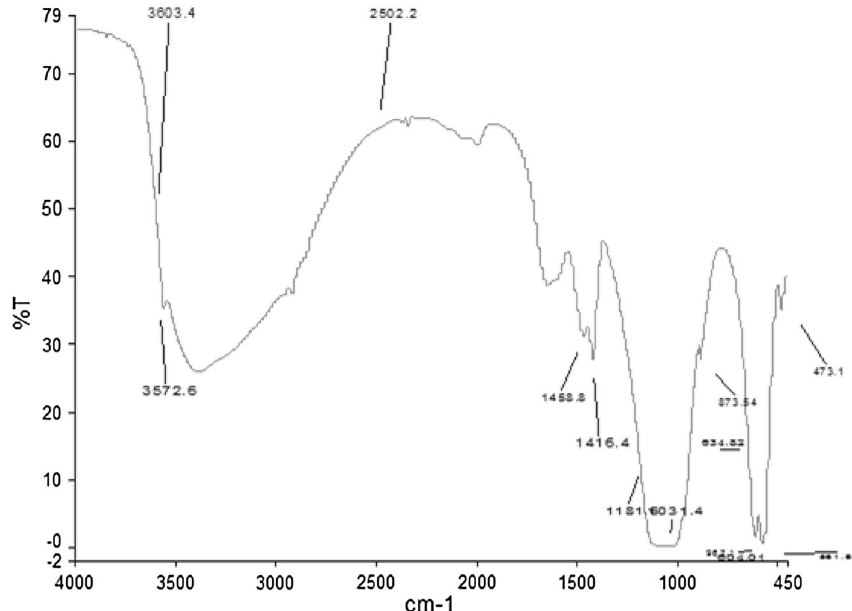
Fig. 2 FT-IR spectrum of syn- thesized HA